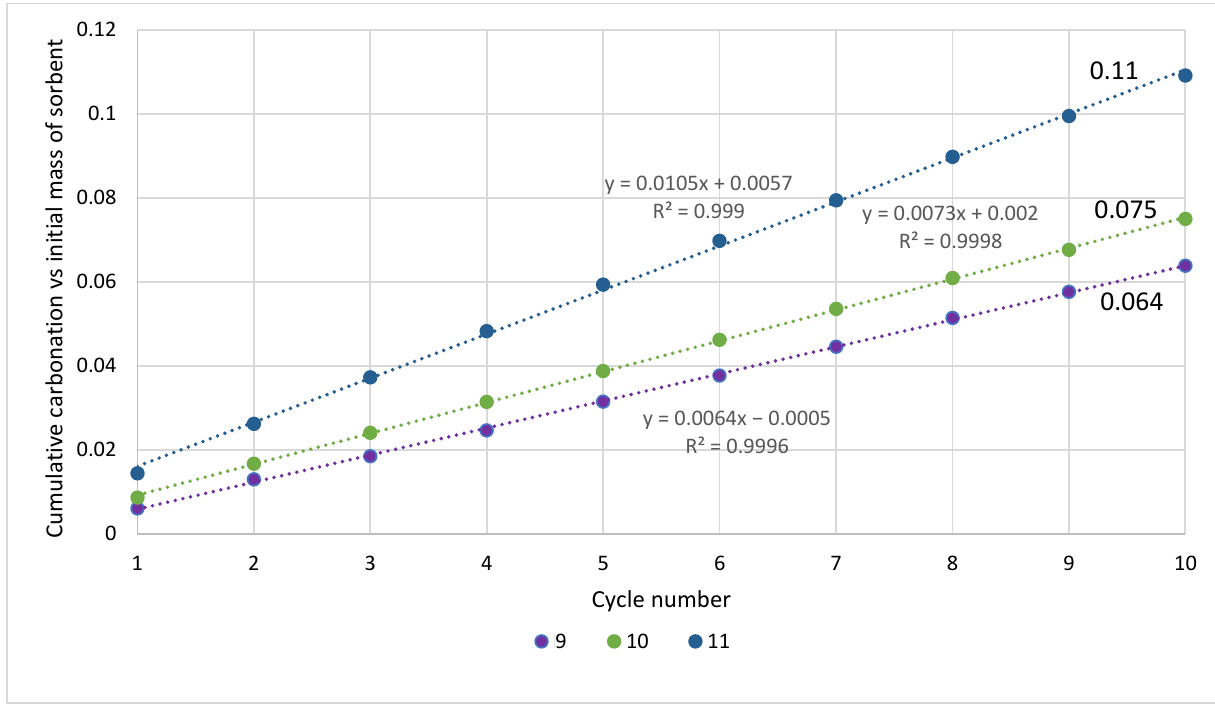
Figure 19. Cumulative carbonation relative to the initial mass of the sorbent—non-carbonate rocks. The CaL simulations performed for the thermally pretreated samples also demon- strated different degrees of conversion for the tested rock sorbents (Table 2). As predicted, they were the highest for the Stramberk limestone sample, which was characterized by the highest proportion of calcium carbonate. The decrease in conversion with subsequent CaL cycles was most apparent for the sorbents with the highest values of this parameter.